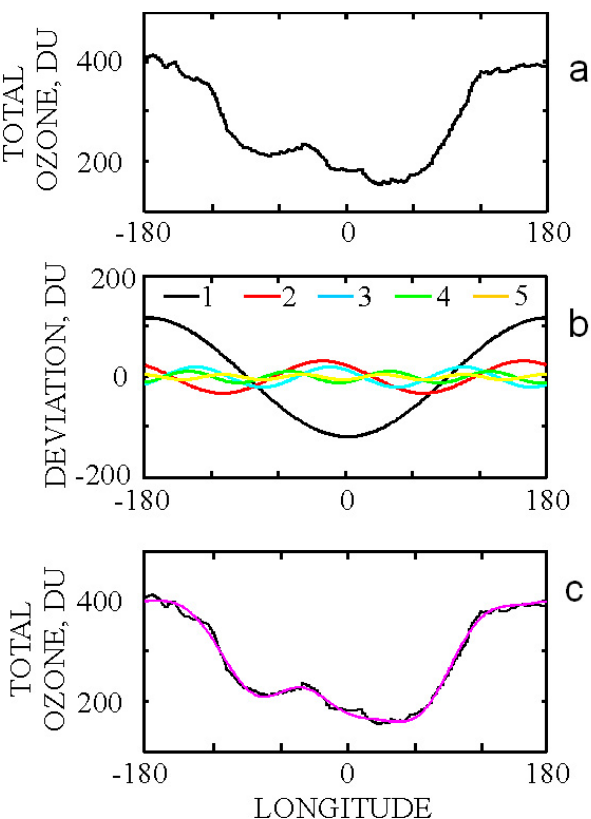
Fig. 1. The distribution of the TOMS total ozone values along 65 ◦ S, 15 October 1996 (a) , the spectral components of the wave numbers 1–5 (b) and comparison of the observed and the restored distributions (c)